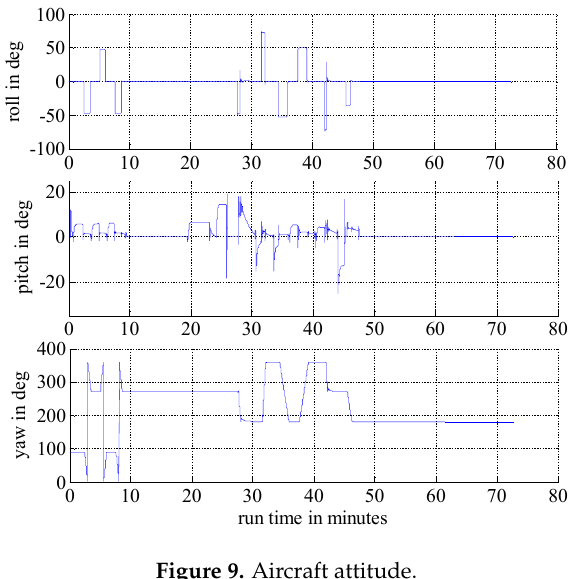
Figure 9. Aircraft attitude. Table 1. Biases and power spectra of the SINS sensors.